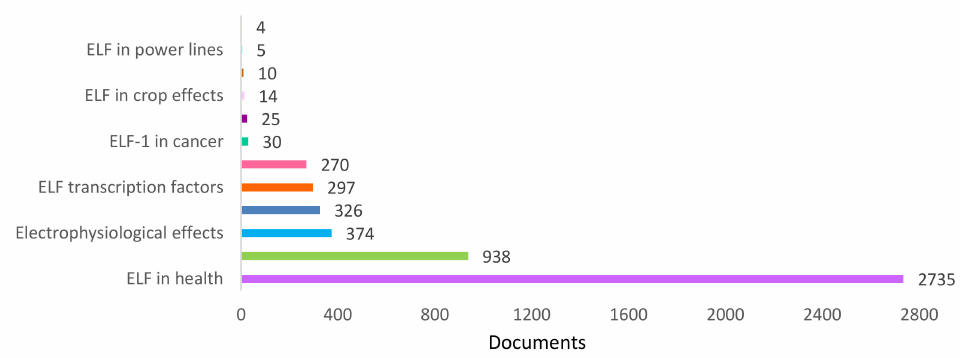
Figure 2. Representation of the distribution of the works in each of the communities.